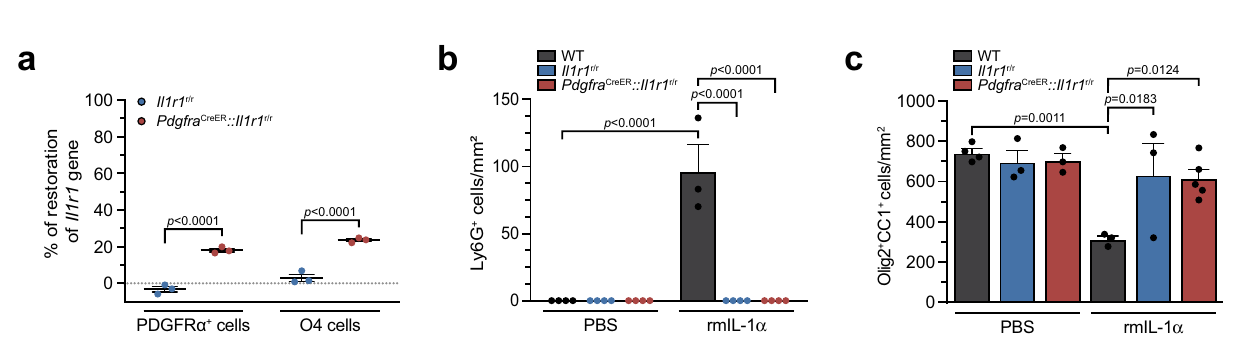
Fig. 5 | Restoration of the Il1r1 gene in oligodendrocyte lineage cells does not lead to IL-1 α -mediated neuroin fl ammation and oligodendrocyte loss. a Quanti fi cationofrestorationof Il1r1 geneexpressioninprimaryPDGFR α + andO4 + oligodendrocyte lineage cells isolated by immunopanning from the uninjured spinal cord of adult Il1r1 r/r mice, who express an IL-1R1-knockout phenotype, and Pdgfra CreER :: Il1r1 r/r mice at 50 days post-tamoxifen treatment ( n =3 per group and each sample has a pool of 4 mice). b Quanti fi cation of the number of Ly6G + neu- trophils that in fi ltrated the spinal cord of WT, Il1r1 r/r and Pdgfra CreER :: Il1r1 r/r mice